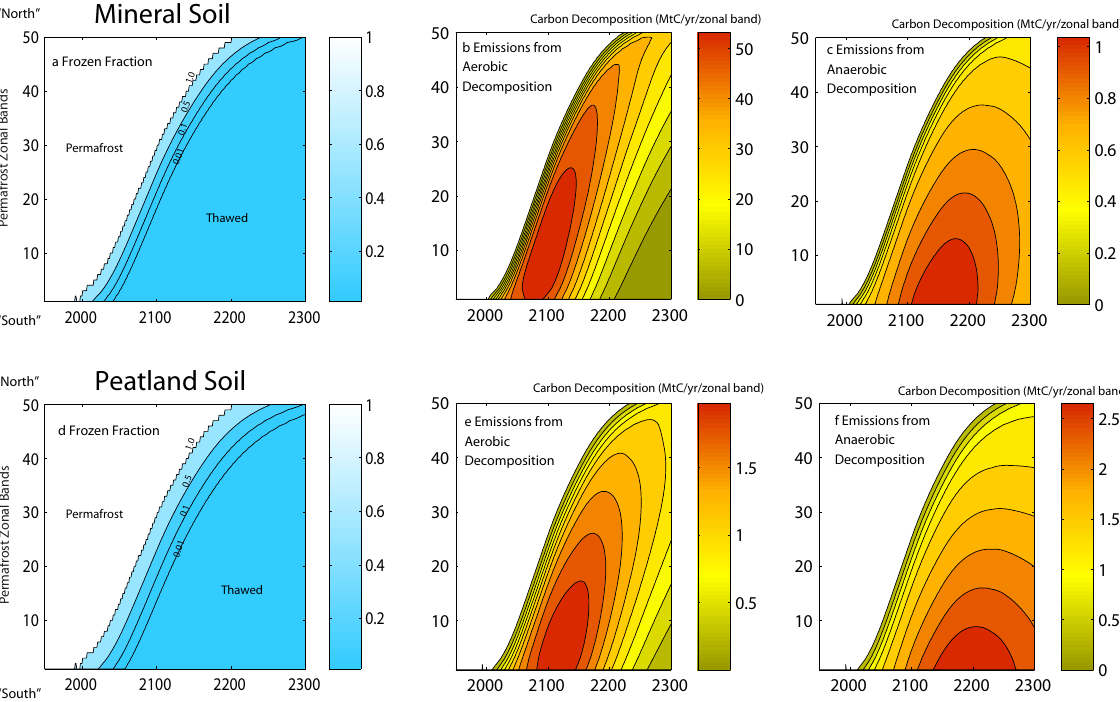
Fig. 2. Fraction of intact near-surface permafrost and carbon release in MtCyr − 1 per zonal band from mineral soil (upper row) and peatland soil (lower row) via aerobic (b, e) and anaerobic (c, f) decomposition, respectively, under the RCP8.5 scenario and illustrative default settings (see text and Table 2). Starting in the “Southernmos” zonal band, the thawing of the parameterized 3m thick soil layer progresses northward to colder zonal bands (vertical axis) over time (horizontal axis) (see a, d ), being followed by carbon